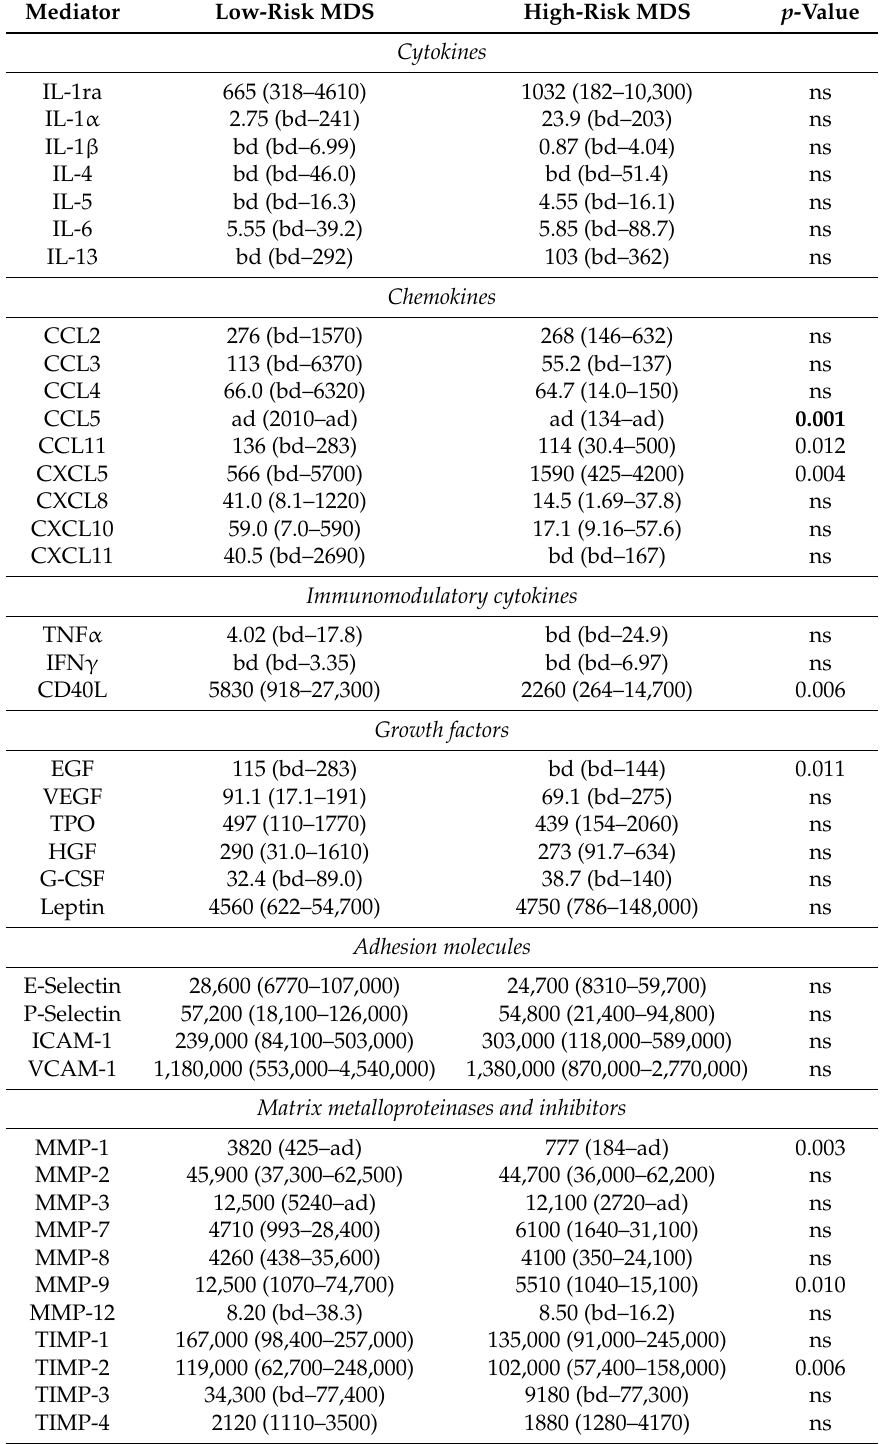
Table 2. Serum levels of soluble mediators; a comparison between low- and high-risk MDS